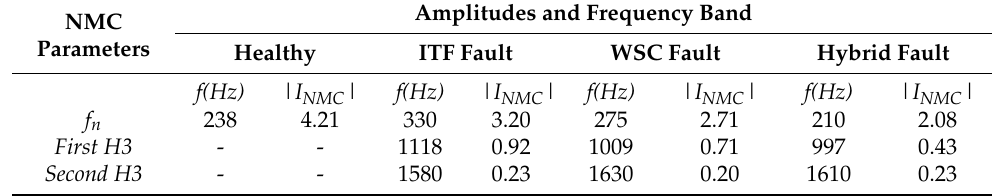
Table 3. NMCSA results.